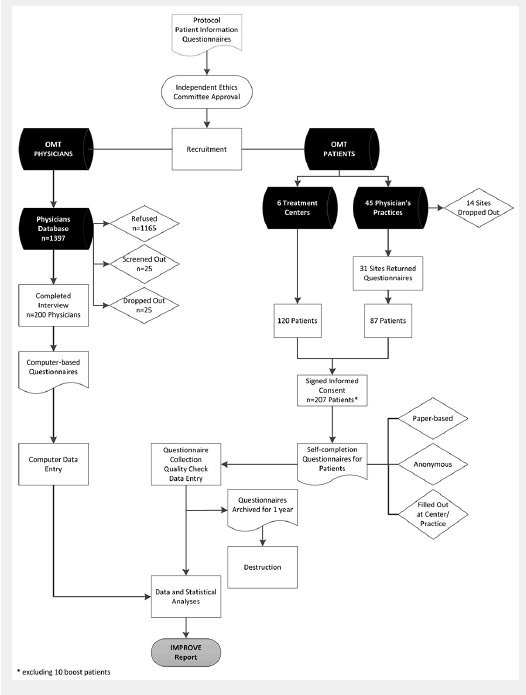
The Swiss IMPROVE study flow chart and disposition of subjects. OMT = opioid maintenance